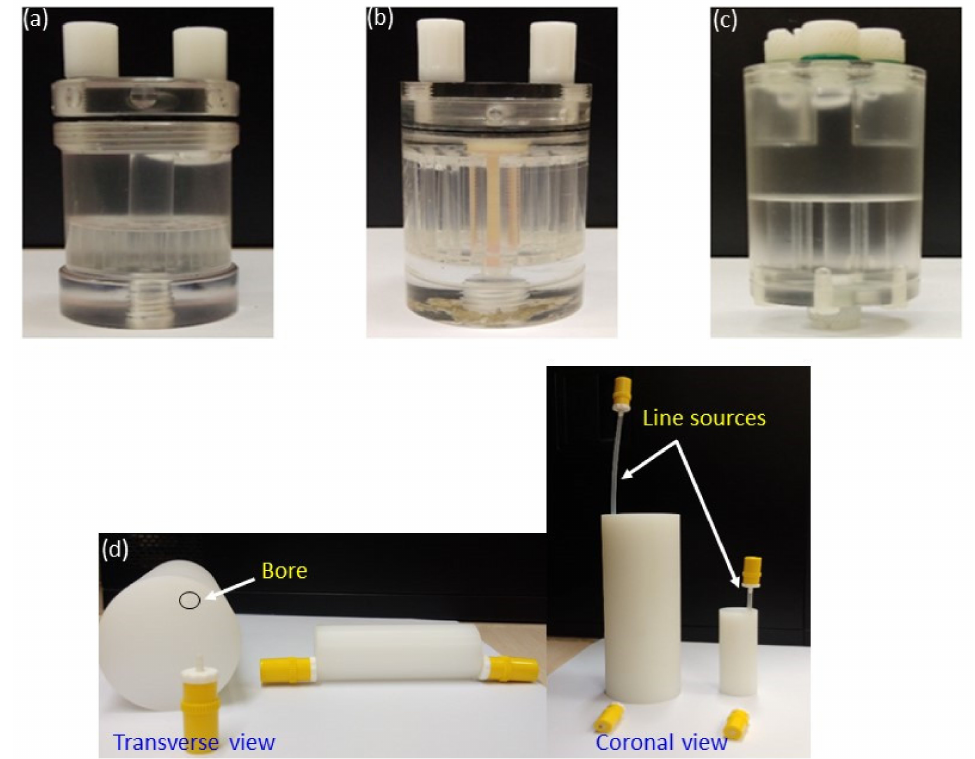
Figure 2. The pictures of NEMA standard and Derenzo phantoms. ( a ) Mouse-sized Derenzo phan- tom, ( b ) rat-sized Derenzo phantom, ( c ) image quality phantom, and ( d ) mouse and rat-sized scatter